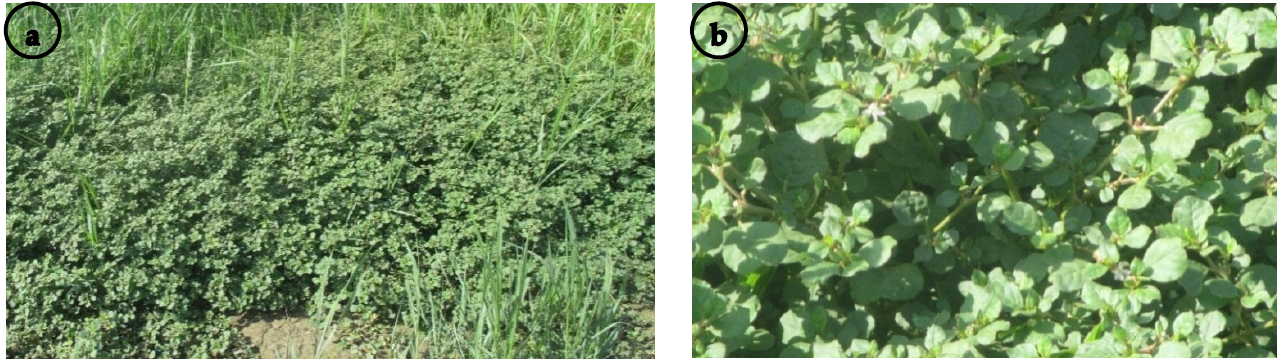
Figure 1. ( a , b ) Photographs of Trianthema portulacastrum in its natural habitat, taken by the au- thors.